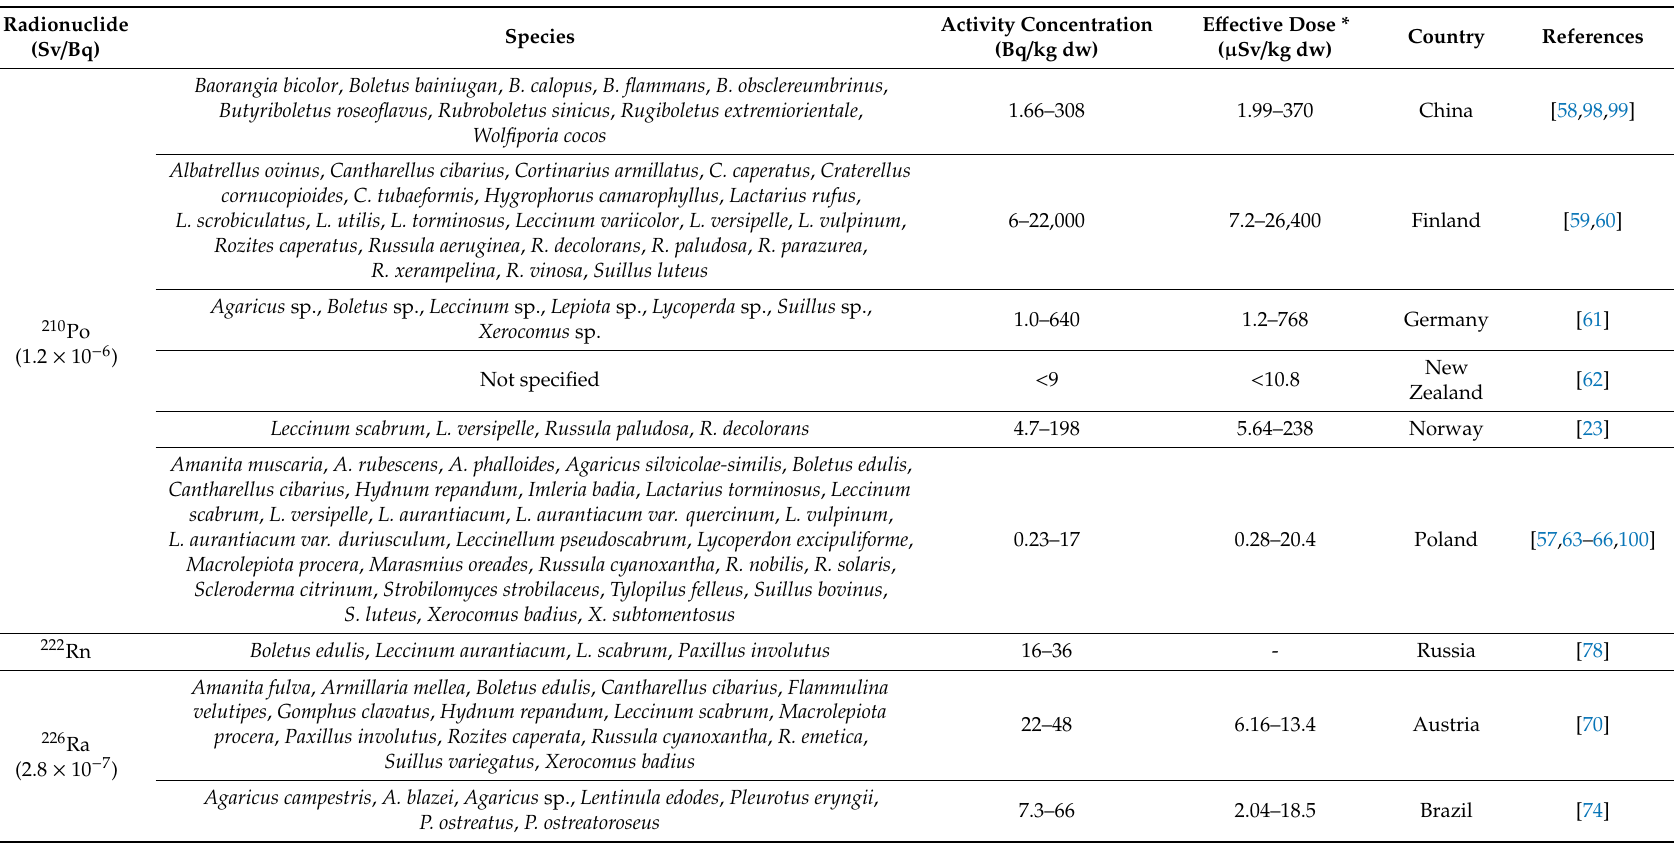
Table 1. The activity concentration ranges of naturally occurring alpha-emitting radioisotopes in wild-growing mushrooms (the Latin names of the species are cited as described by the authors—the current names of some species can be found on the Index Fungorum web site) collected from di ff erent countries as well as the e ff ective dose from mushrooms consumption presented as a proportion of total dietary consumption ( µ Sv / kg dw) (* calculation based on the isotopic activity concentration and e ff ective dose coe ffi cients (Sv / Bq) for ingestion of radionuclides for adults